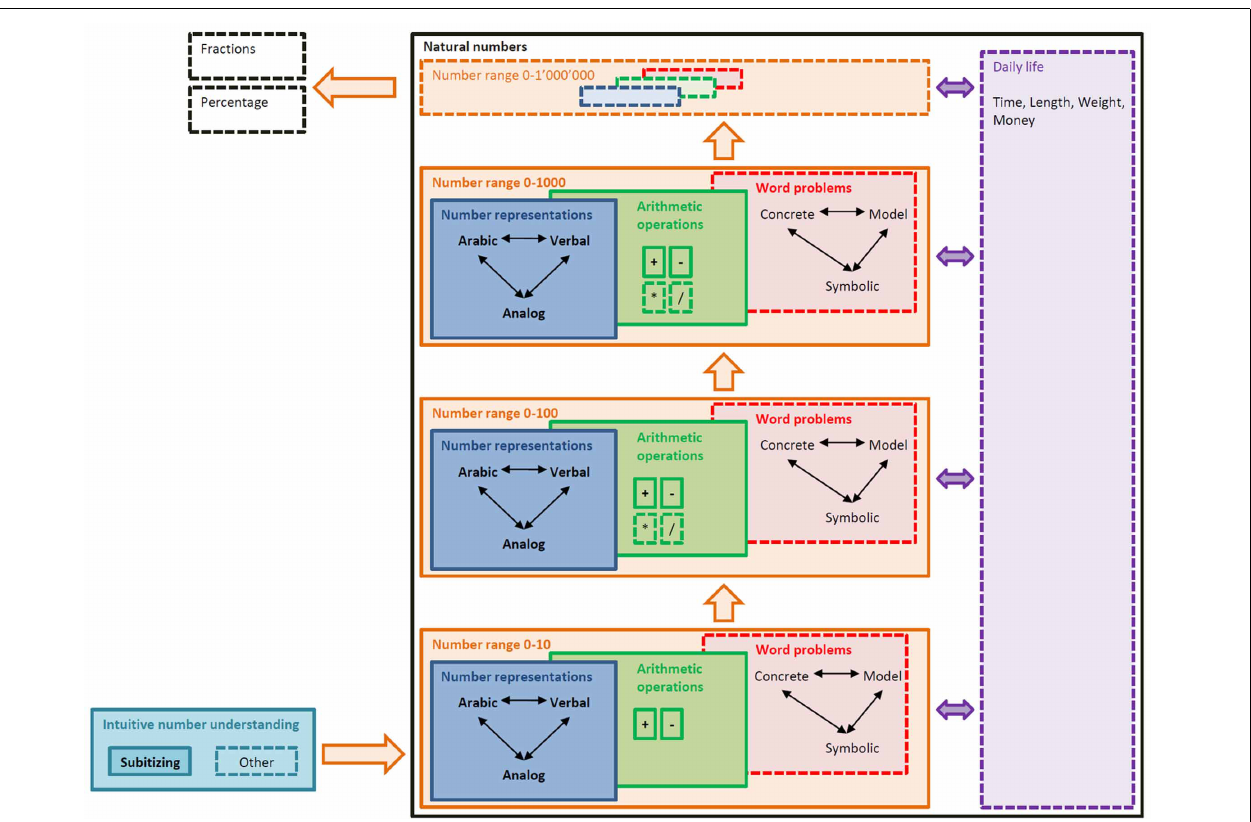
FIGURE 2 | Target structure of the training program. The continuous lines mark the areas present in the study version.